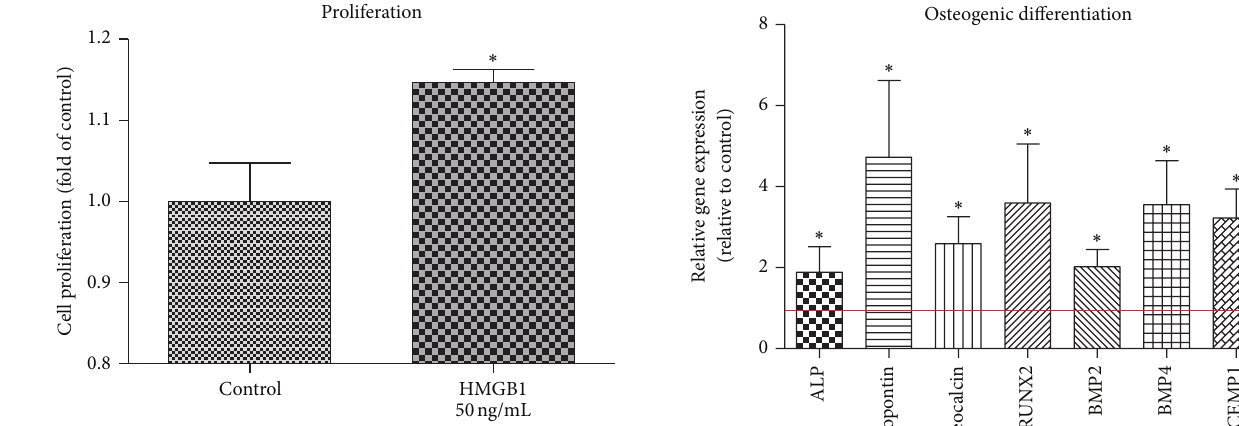
Figure 1: HMGB1 enhances PDL cell proliferation. As determined by MTS assay, HMGB1 stimulation resulted in an increase in hPDL cellsproliferation.Datarepresentthemean ± SDforsixindependent cultures. ∗ 𝑃 < 0.05 , experimental group versus untreated control.